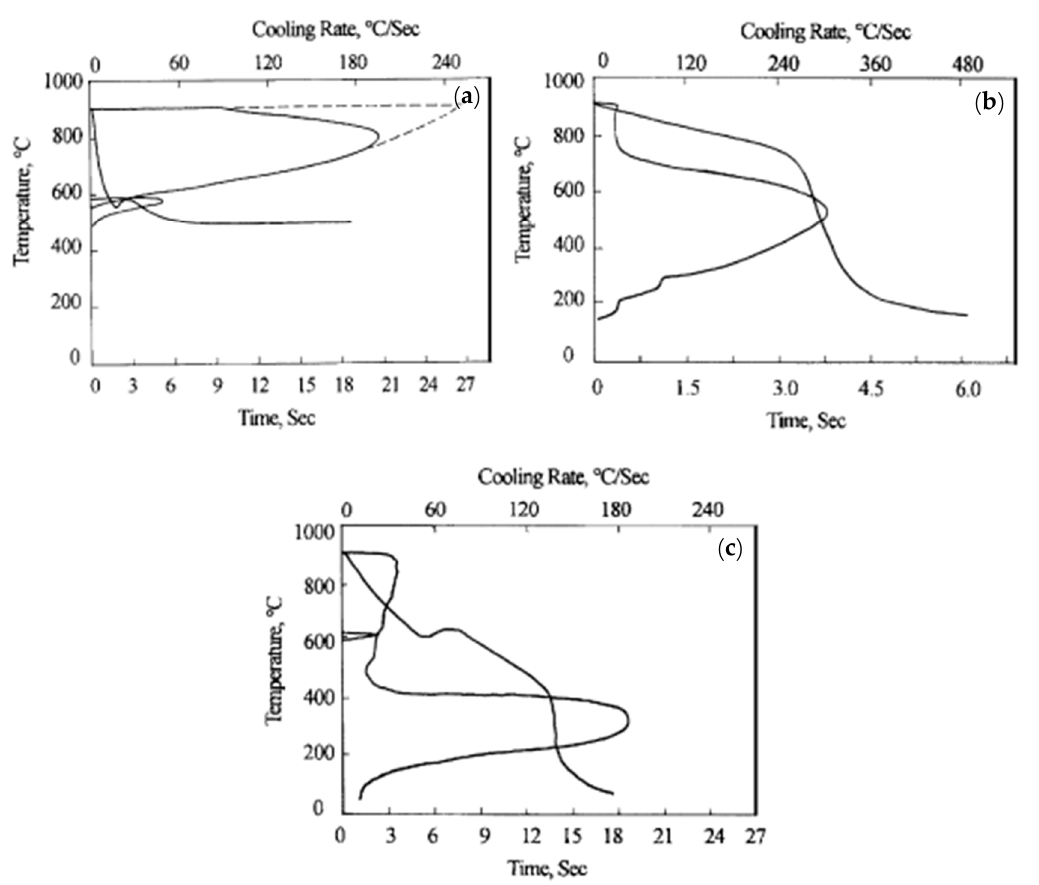
Figure 16. Cooling rate curves of steel wire in different cooling media: ( a ) 505 °C, lead bath; ( b ) 0.10% CMC, water bath; and ( c ) 0.25% CMC, water bath. Reprinted with permission from ref. [24].